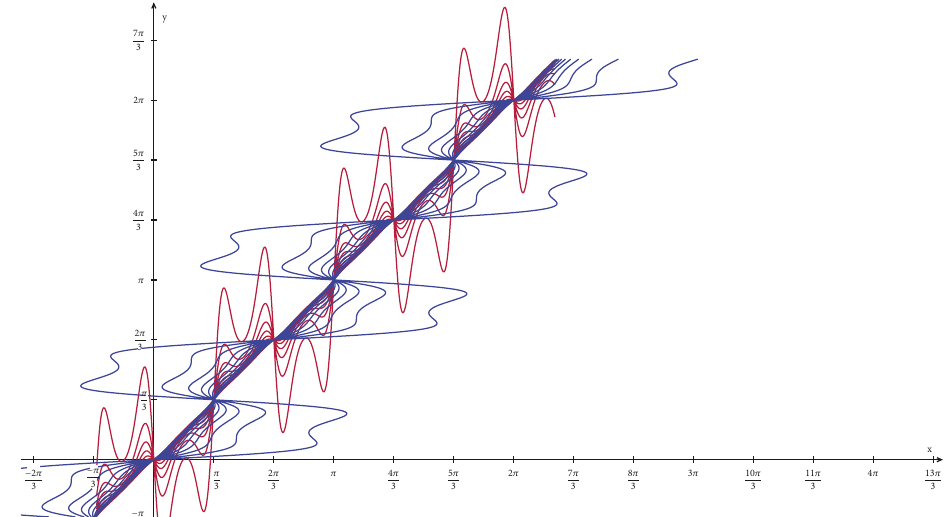
Figure 7: The figureshows a parametric plot of families of curvesfor system (9) for Ξ (𝑥) = 𝑥−𝜅 𝑥 𝑔 1 ( sin (3𝑥)) sin (3𝑥) , 𝜅 𝑥 = −0.66 , and different relatives weights 𝛼 = 0.1,0.2,. .. ,0.9 (red lines), Ξ (𝑦) = 𝑦−𝜅 𝑦 𝑔 2 ( sin (3𝑦)) sin (3𝑦) , 𝜅 𝑦 = 0.66 and different relative weights 𝛿 = 0.1,0.2, .. ., 0.9 (blue lines). The intersections correspond to different fixed points of different pairs of equations. Notice that only those fixed points of the form (𝑝, 𝑝) are common to all equations in system (7); however, they are unstable. Other fixed points depend on parameters’